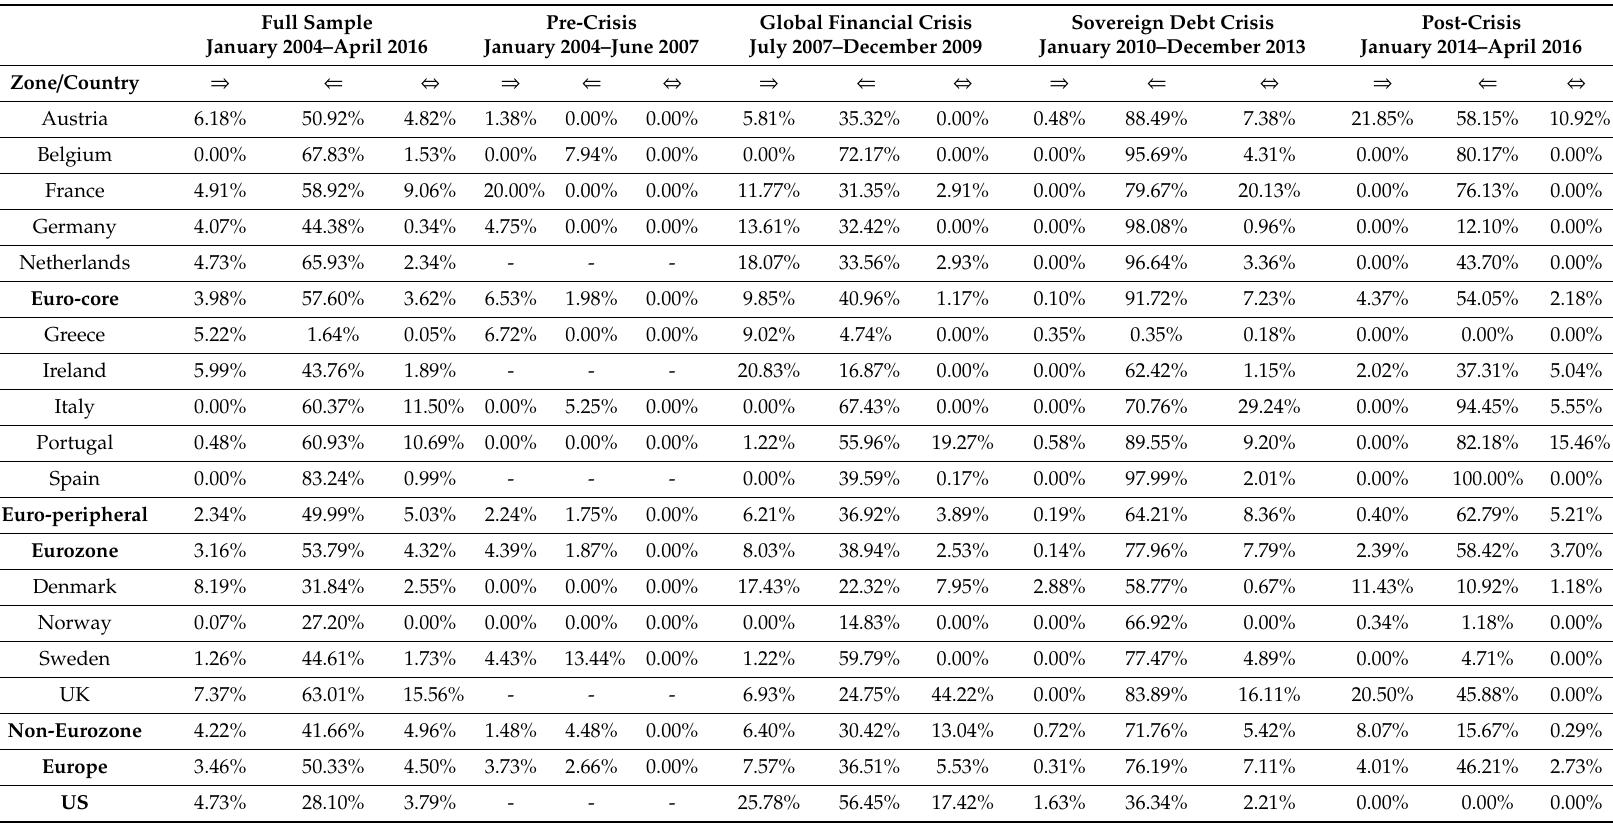
Table 3. Granger causality test results: stock return volatility and CDS